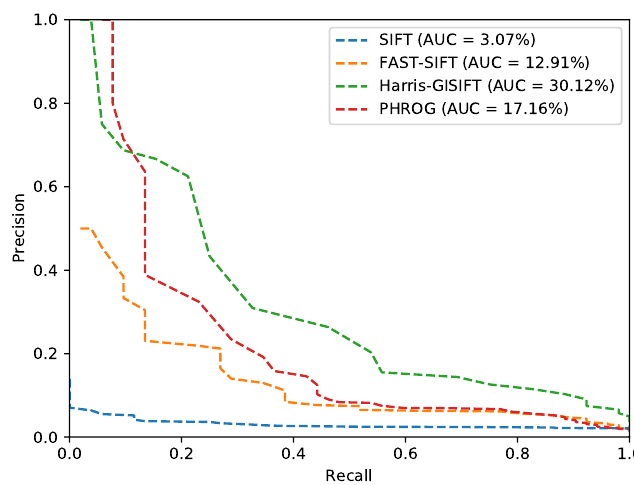
Figure 16. Precision-Recall curves from the “country” dataset and AUC ( Area Under the Curve ) for each method.